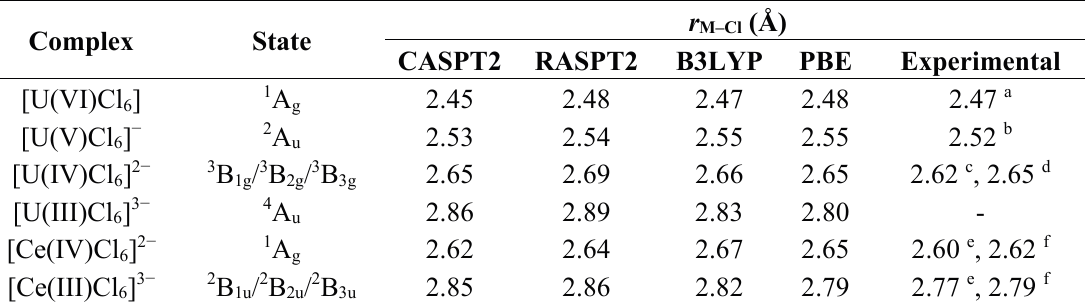
Table 1. Ground states and calculated optimal bond-lengths for all complexes considered in this